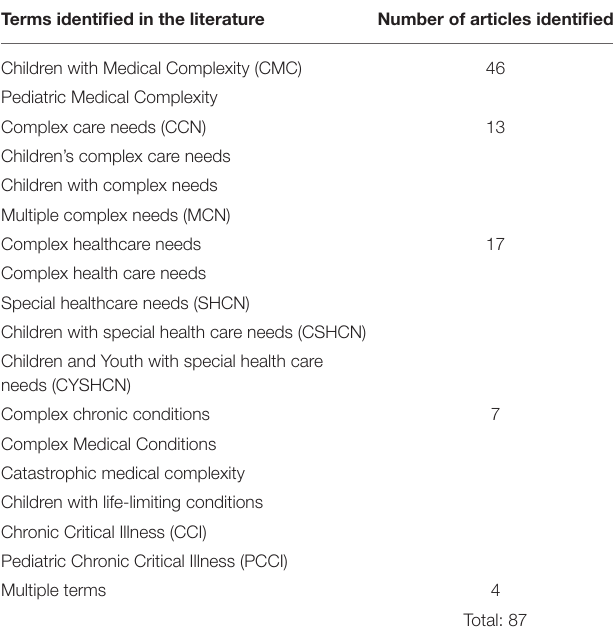
TABLE 1 | Terms used in the literature to refer to children with complex care needs. Terms identified in the literature Number of articles